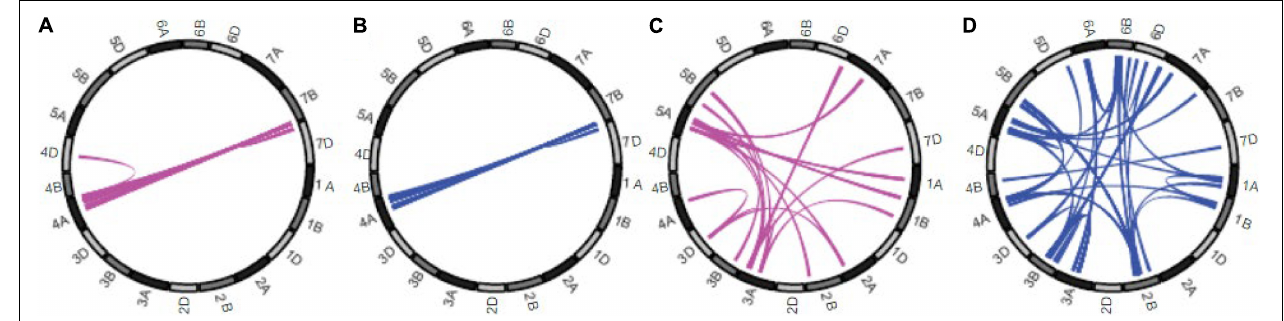
FIGURE 1 | Genetic architecture of mid-parent heterosis for grain yield. Results for the 21 wheat chromosomes shown around the circumferences. Colored links in the centers of the circles represent significant digenic epistatic interactions: additive by dominance for elite hybrids (A) and for exotic × elite (C) , dominance by dominance for elite hybrids (B) and for exotic × elite (D) . Taken from Boeven et al. (2020).